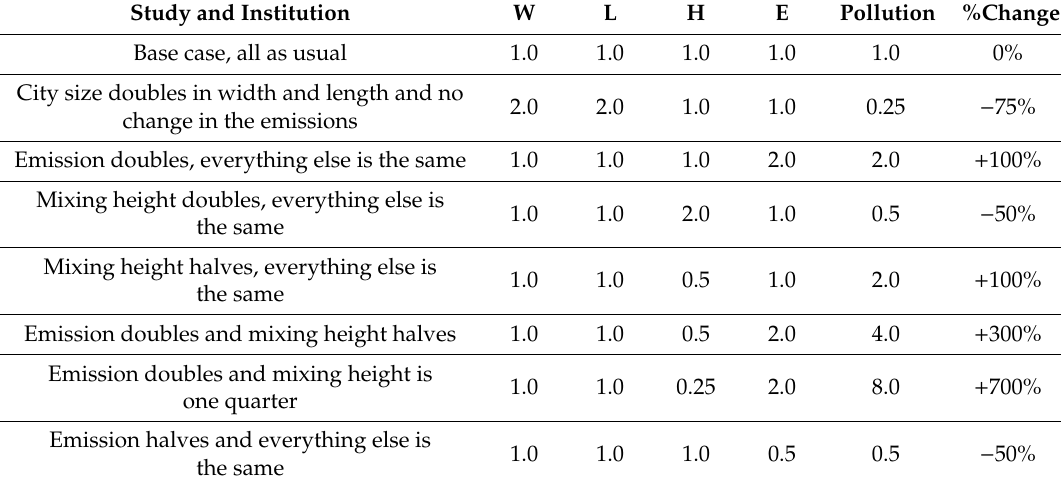
Table 1. A hypothetical pollution calculation for a city using a steady state box model method. W = width of the city; L = length of the city; H = mixing height; E = emissions.